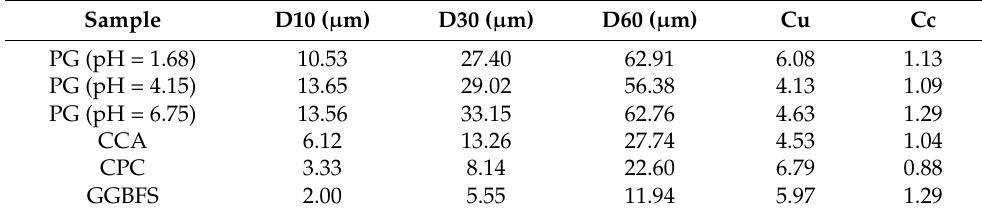
Figure 2. Particle size distribution of PG, CCA, PC and GGBFS [30,37]. Table 1. Physical properties of PG, CCA, PC and GGBFS.